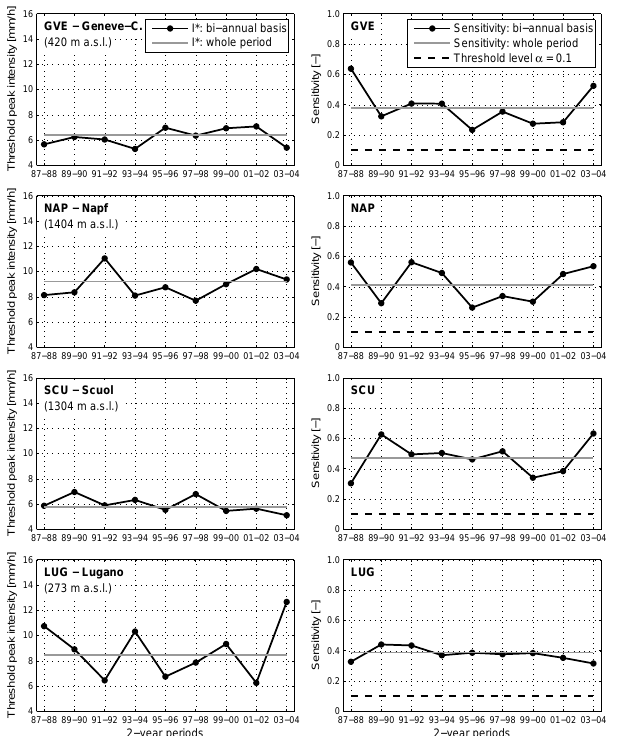
Fig. 7. Threshold peak intensity I ∗ estimated on a bi-annual basis (left column) and the sensitivity corresponding to I ∗ on a bi-annual basis (right column) at the studied stations. The dashed horizontal line on the right panels denotes the chosen misclassification error α = 0 .